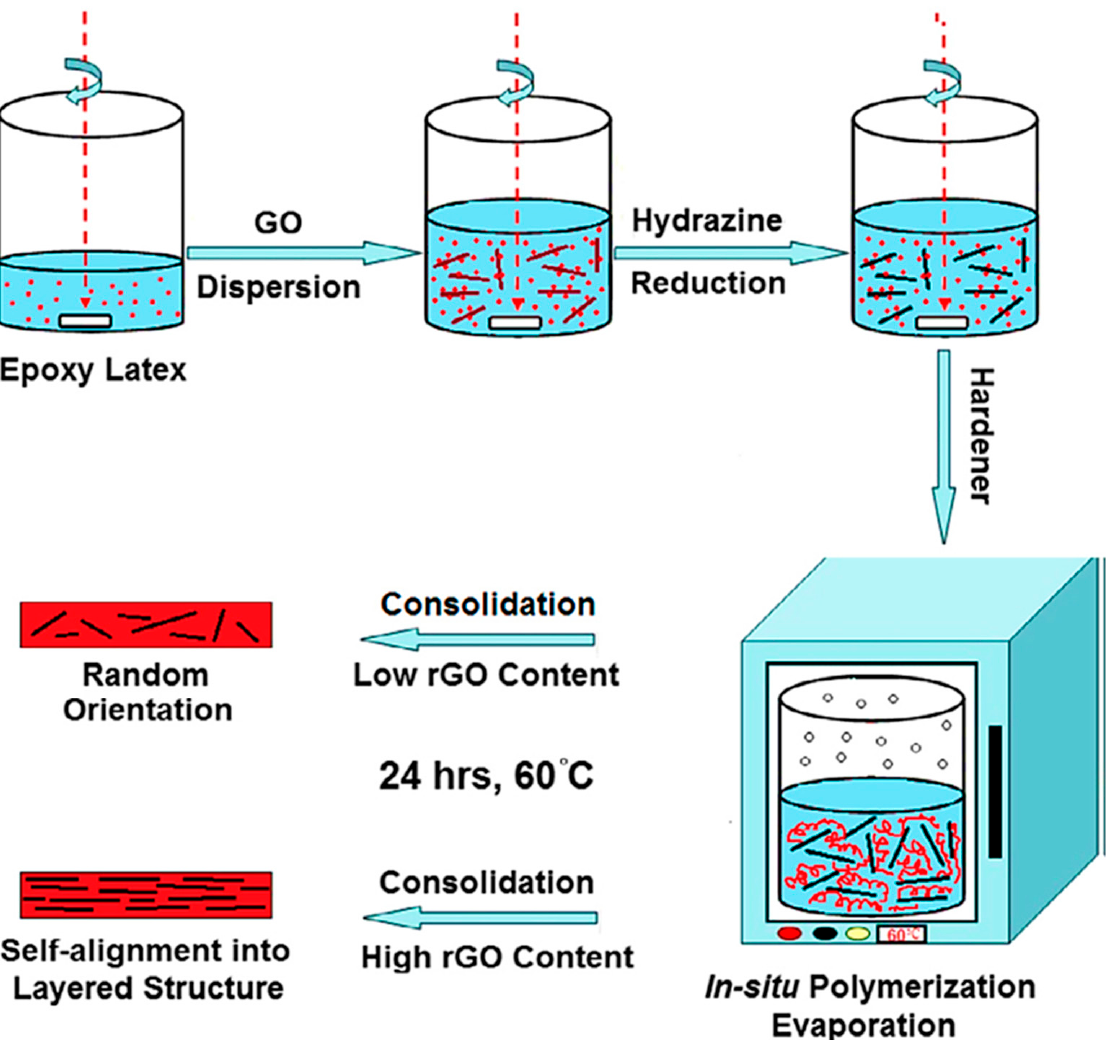
Figure 6. Schematic of nanocomposite preparation. Reprinted with permission from [113]. 2013, Elsevier.